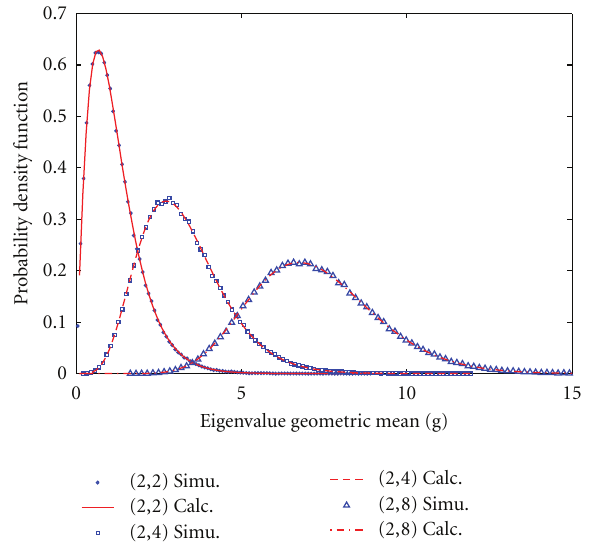
Figure 2: Comparison between simulation and calculation results for distributions of eigenvalue geometric means (link gains of GMD-based transceivers) in (2,2), (2,4), and (2,8) MIMO Rayleigh fading channels.